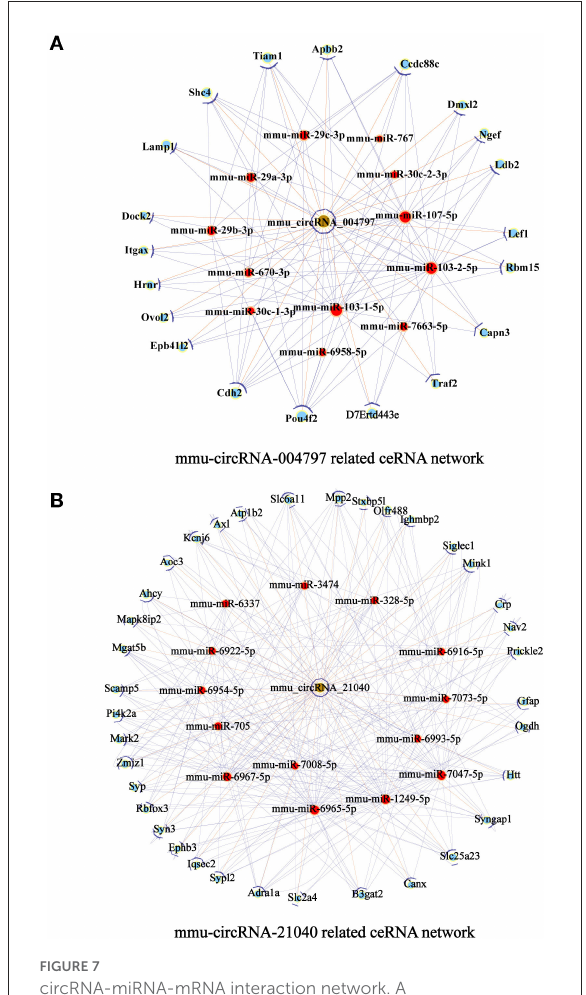
FIGURE7 circRNA-miRNA-mRNA interaction network. A circRNA-miRNA-mRNA interaction network was constructed by ceRNA analysis. (A) The ceRNA relationship pairs included circRNA-004797 as the core nodes, as well as 12 target miRNAs and 20 target mRNAs. (B) The ceRNA relationship pairs included circRNA-21040 as the core nodes, as well as 14 target miRNAs and 36 target mRNAs. Nodes with brown color represent circRNAs, while nodes with light-blue color are protein_coding RNAs. Nodes with red color represent the predicted miRNAs. Edges with T-shape arrows represent directed relationships Edges without arrows represent undirected relationships (ceRNA relationship). ceRNA, competing endogenous RNA; circRNA, circular RNA; miRNA/miR,